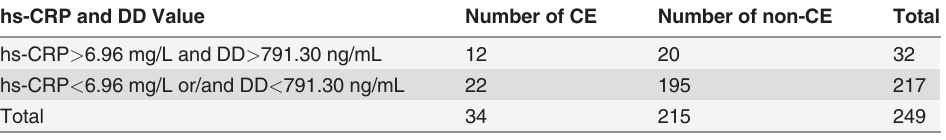
Table 4. Evaluation of hs-CRP and DD in combined diagnosis of CE (series of diagnostic tests). hs-CRP and DD Value Number of CE Number of non-CE